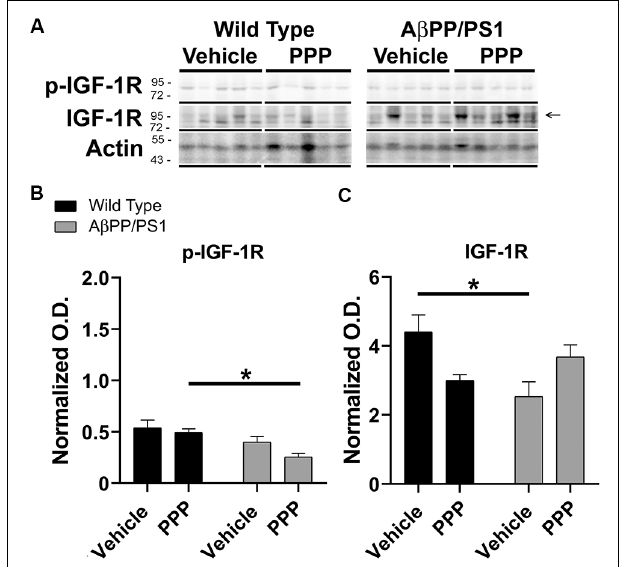
FIGURE 4 | Liver p-IGF-1R levels were altered by inhibitor treatment in A β PP/PS1 mice. Liver lysates from the vehicle and PPP (1 mg/kg, 7 days) treated WT and A β PP/PS1 mice were (A) western blotted to quantify (B) p-IGF-1R and (C) IGF-1R protein changes. p-IGF-1R blots were normalized to their respective IGF-1R loading controls. Actin was used as a loading control for normalizing IGF-1R blots. Data are mean O.D. ± SEM, * p < 0.05 ( n = 5 animals). Two-way ANOVA indicate p-IGF-1R F (1,16) = 0.9666 and p (interaction) = 0.3402 and IGF-1R F (1,16) = 11.39 and p (interaction) = 0.0039. The errors from comparisons of several pairs of means in the experiment were adjusted using Tukey’s multiple comparison